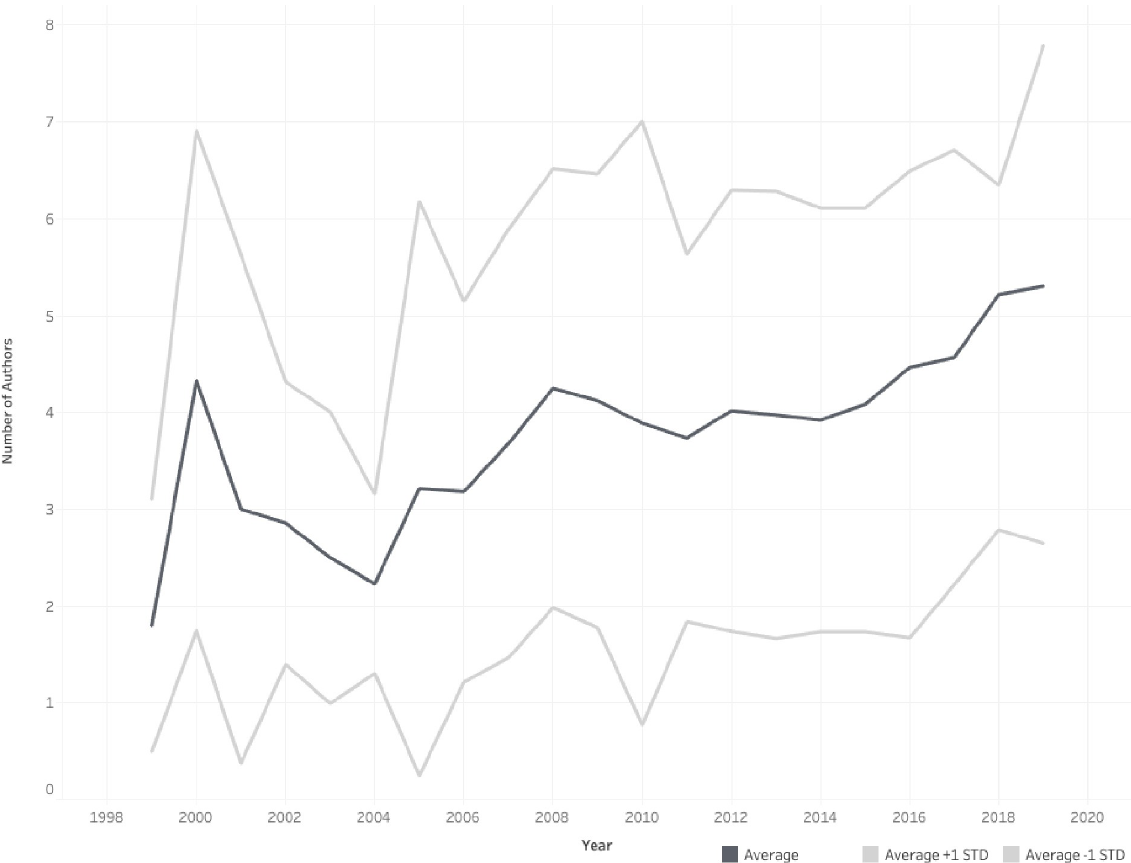
Fig 1. The median number of authors per knowledge synthesis (10th and 90th percentiles also shown) published in 14 core medical education journals published between 1999–2019.